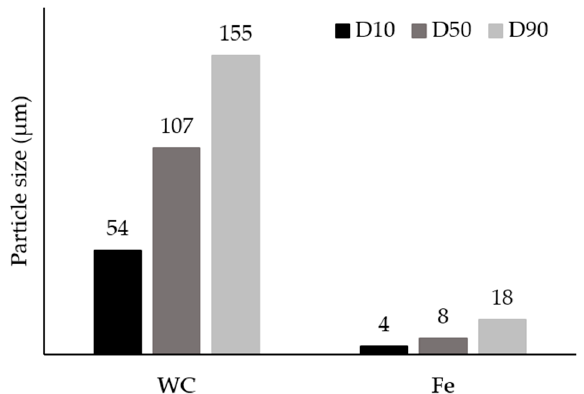
Figure 5. Analysis of the particle size distribution by dynamic light dispersion (DLS), indicating parameters D 10 , D 50 and D 90 of the initial powders.